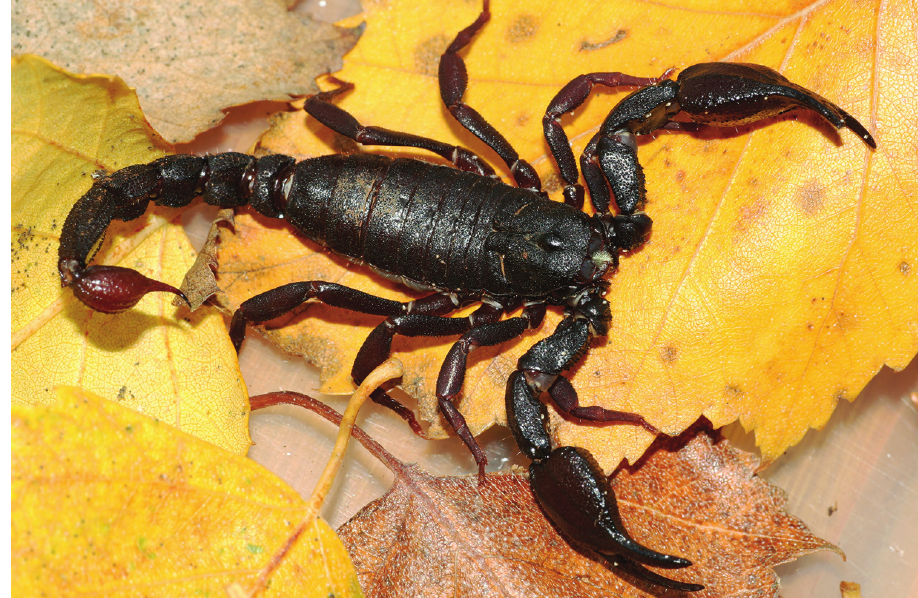
Figure 24. Brotheas granulatus , male from